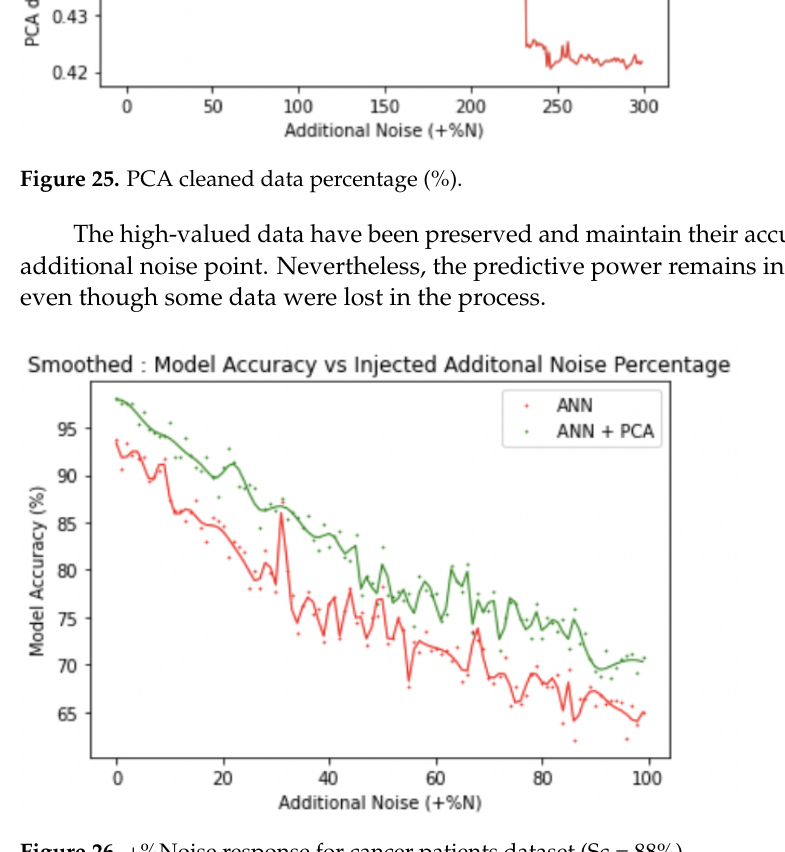
Figure 26. +%Noise response for cancer patients dataset (Sc =